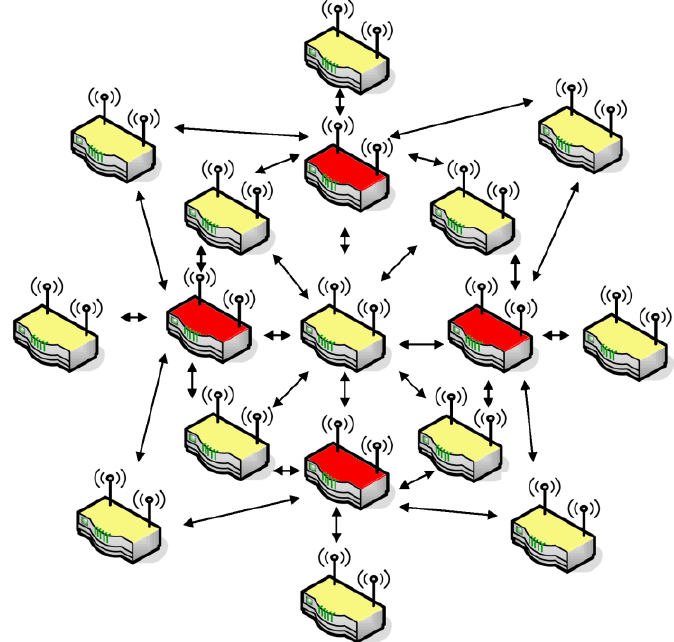
Figure 3. MultiPoint Relays protocol for communication within a dense array, i.e. , how messages from a central node are distributed throughout a cluster. In practice, only a subset of the central node's neighbors (red) need to rebroadcast the